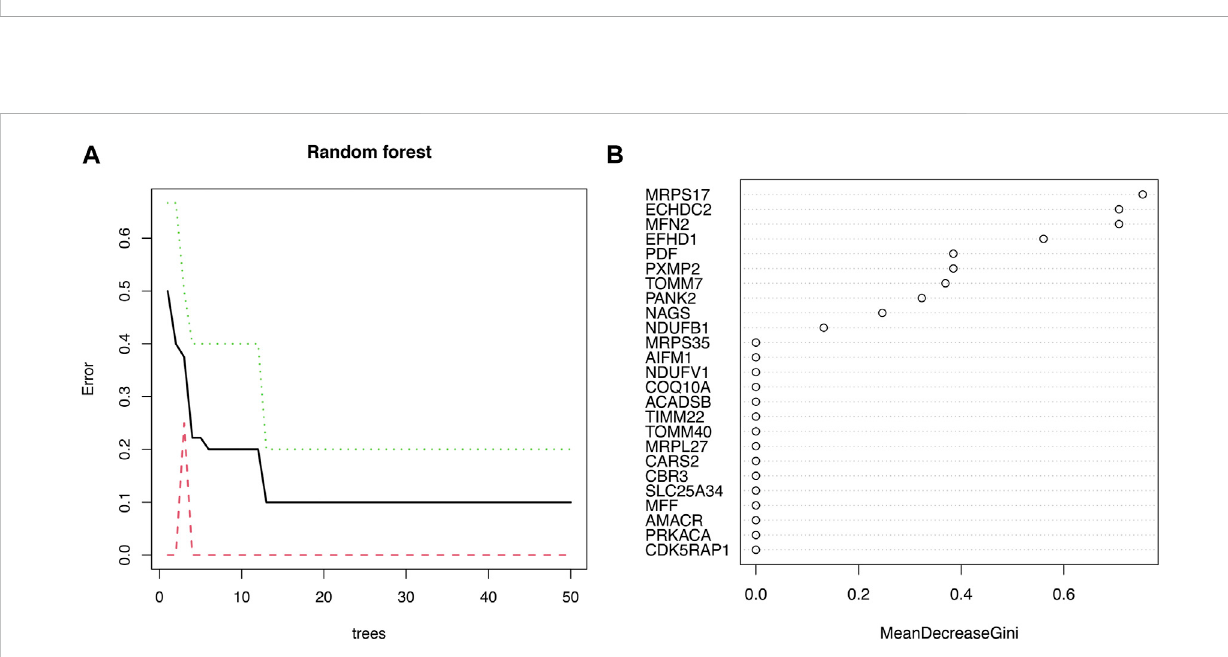
FIGURE 3 Themachinealgorithmsforsignaturegenes. (A) Con fi denceintervalsforerrorratesofrandomforestmodels. (B) Therelativeimportanceofgenesin random forest